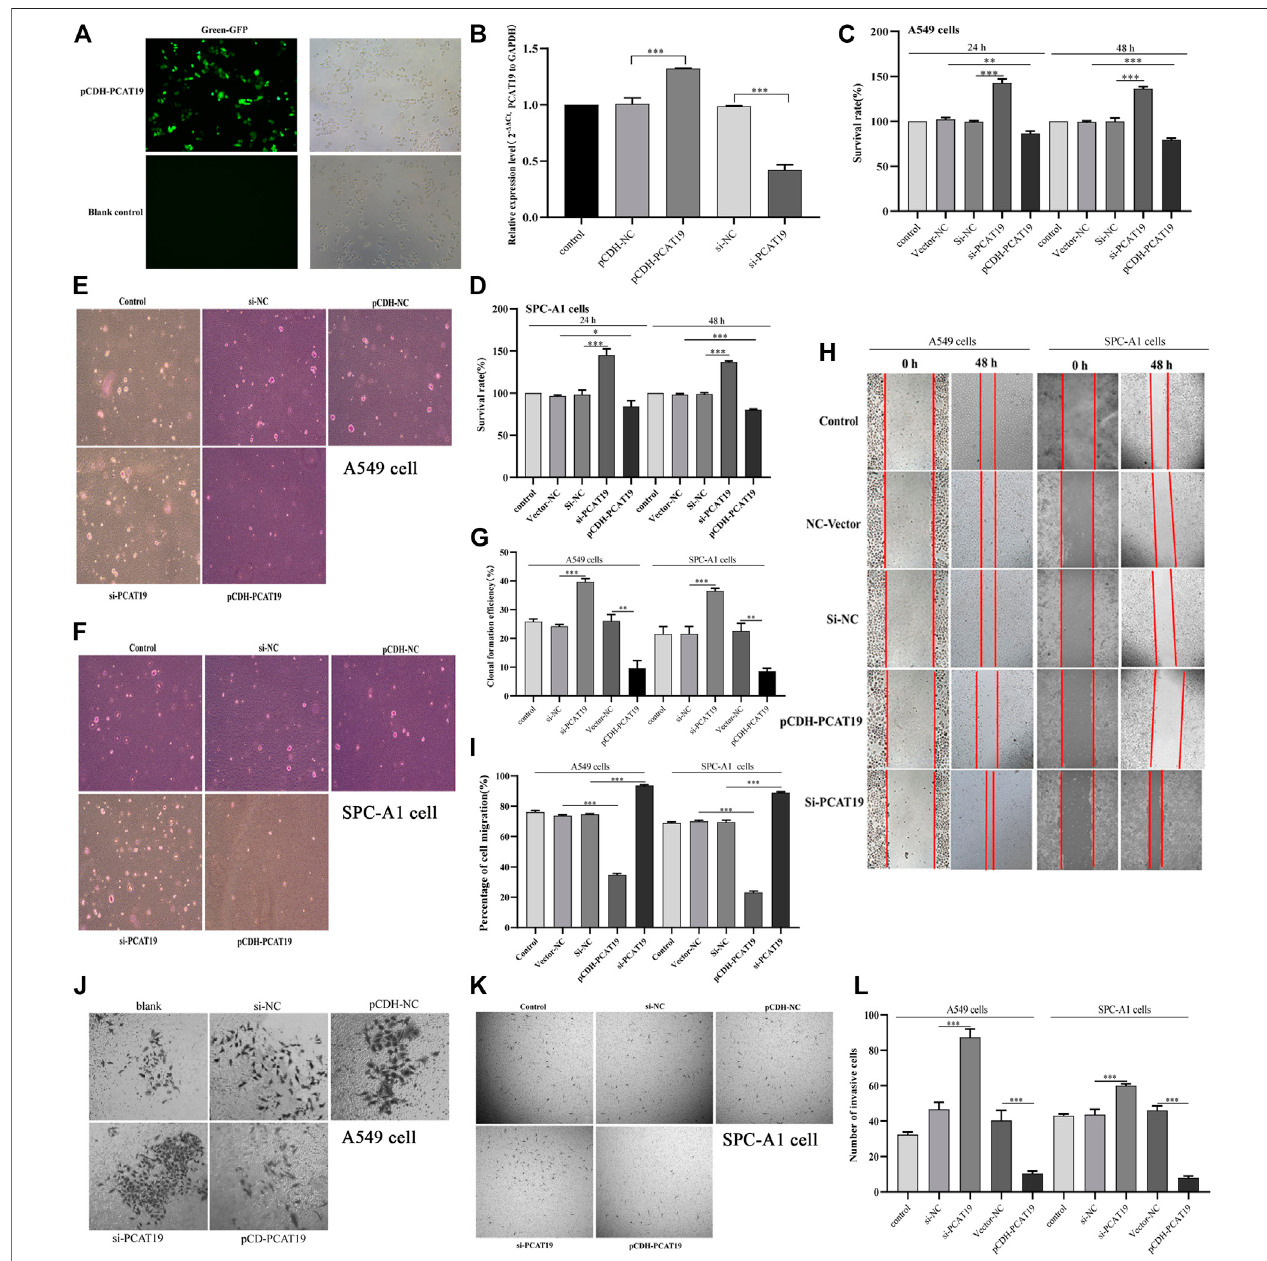
FIGURE 6 | (A) Overexpression of PCAT19 in A549 cells analyzed by fl uorescence observation; (B) transfection ef fi ciency of pCDH-PCAT19 and si-PCAT19 was detected by qPCR; (C) effects of PCAT19 knockdown or overexpression on the vitality of A549 cells measured using the CCK-8 assay; (D) effects of PCAT19 knockdown or overexpression on the vitality of SPC-A1 cells measured using the CCK-8 assay; (E – G) effect of PCAT19 knockdown or overexpression on A549 and SPC-A1cellproliferationmeasuredusingthesoftagarassay. (H,I) effectsofPCAT19knockdownoroverexpressiononA549andSPC-A1cellmigrationmeasured using the migration assay. (J – L) effects of PCAT19 knockdown or overexpression on A549 and SPC-A1 cells invasion using transwell assays. * p < 0.05, ** p < 0.01, *** p <